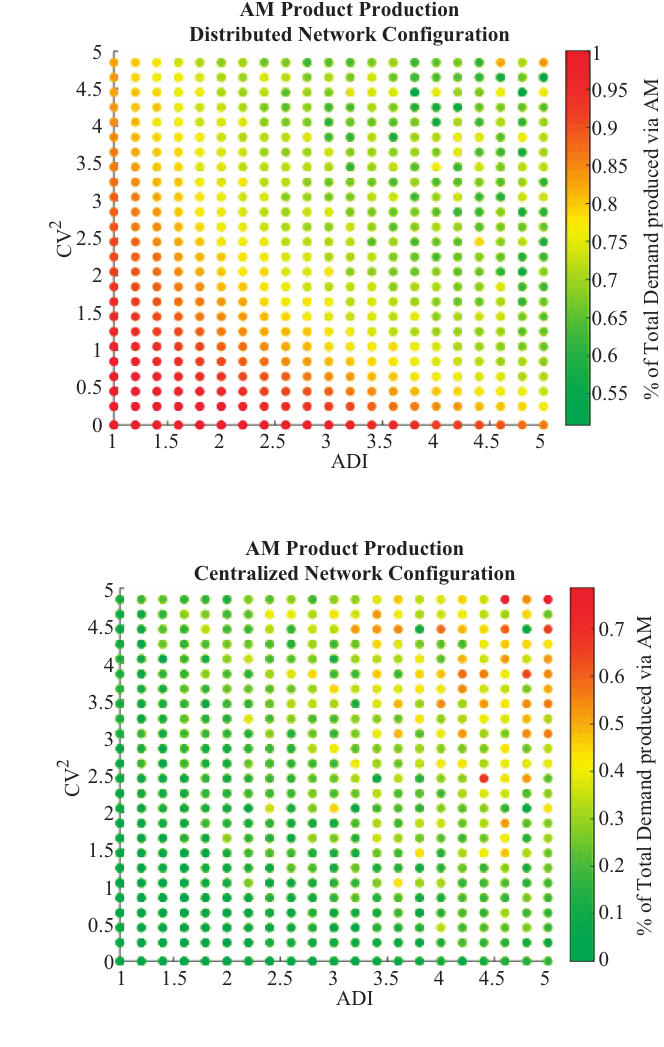
Figure A2. (Color online) Percentage of total demand thatwas produced via AM in the centralizedconfiguration. (Parameters: reactive inventory policy, AM capacity: 4, Average demand: 3, Demand realizations: 500, Products: